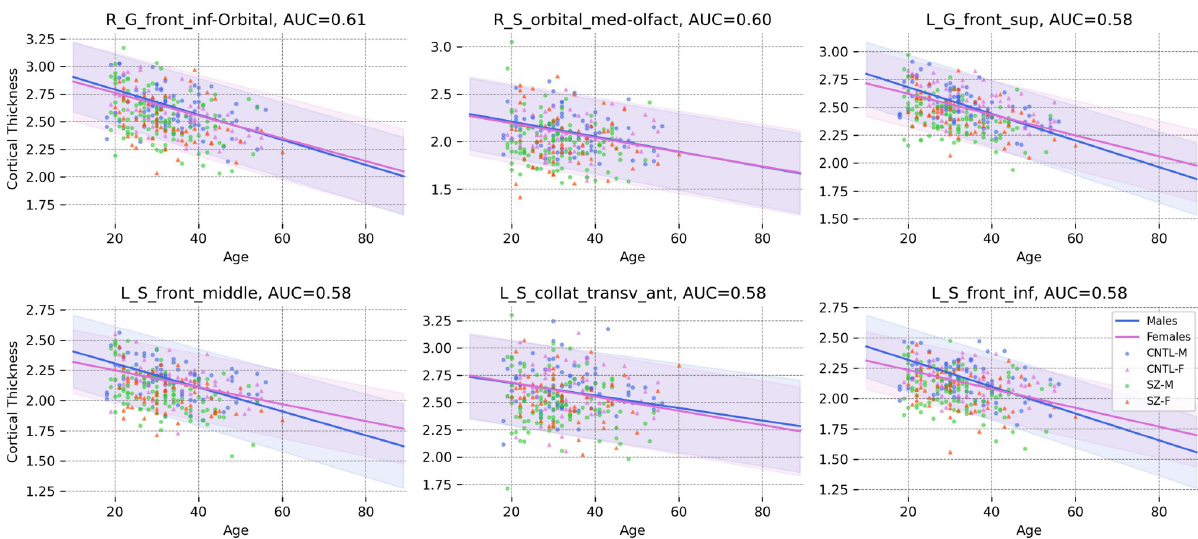
Fig 13. The norm and the 95% normative range for males and females in the 6 most distinctive cortical regions in schizophrenia. Patients show lower cortical thickness than the norm of the population (Abbreviations: CNTL-F = healthy female, CNTL-M = healthy male, SZ-F = female patient, SZ-M = male